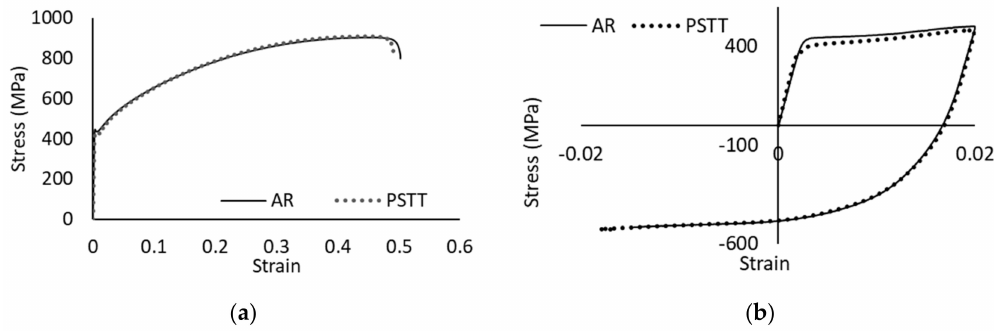
Figure5. HardeningbehaviouroftheInco718material. ( a )Monotonicstress–strainrelation(engineering stress-strain) and ( b ) strain path change and stress–strain